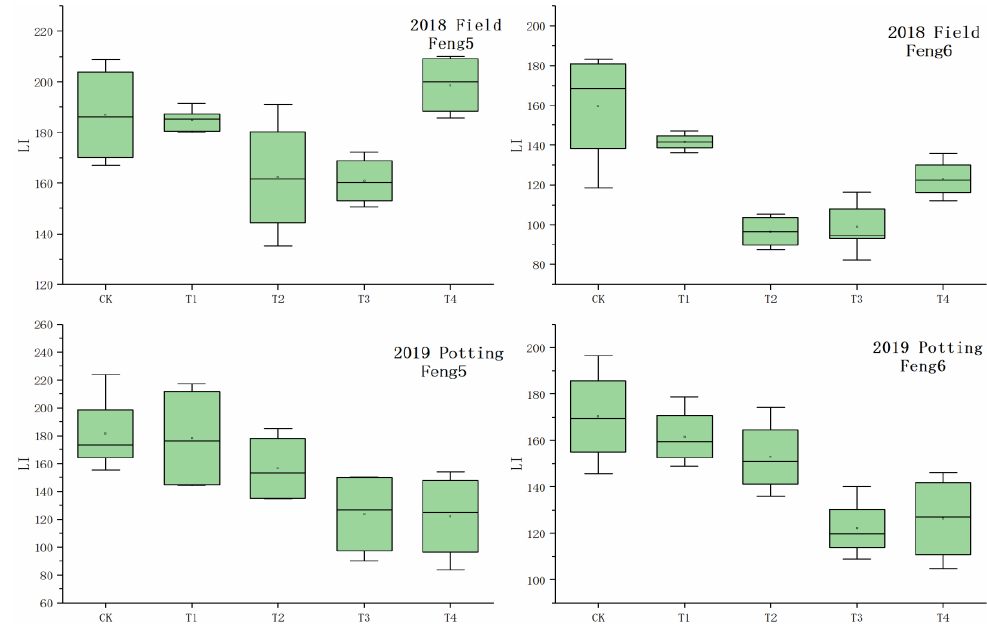
Figure 4. Lodging index (LI) change of giant rice under nitrogen treatment. Table 7. Changes in nitrogen e ffi ciency in giant rice under nitrogen